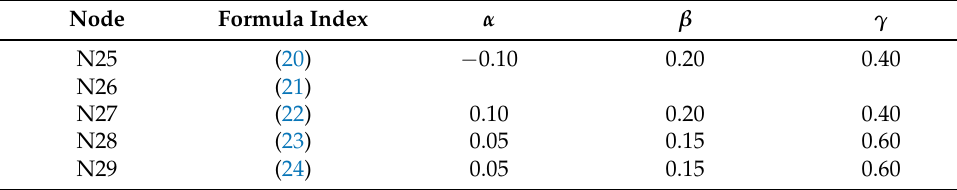
Table 13. Additional processing nodes of five types.